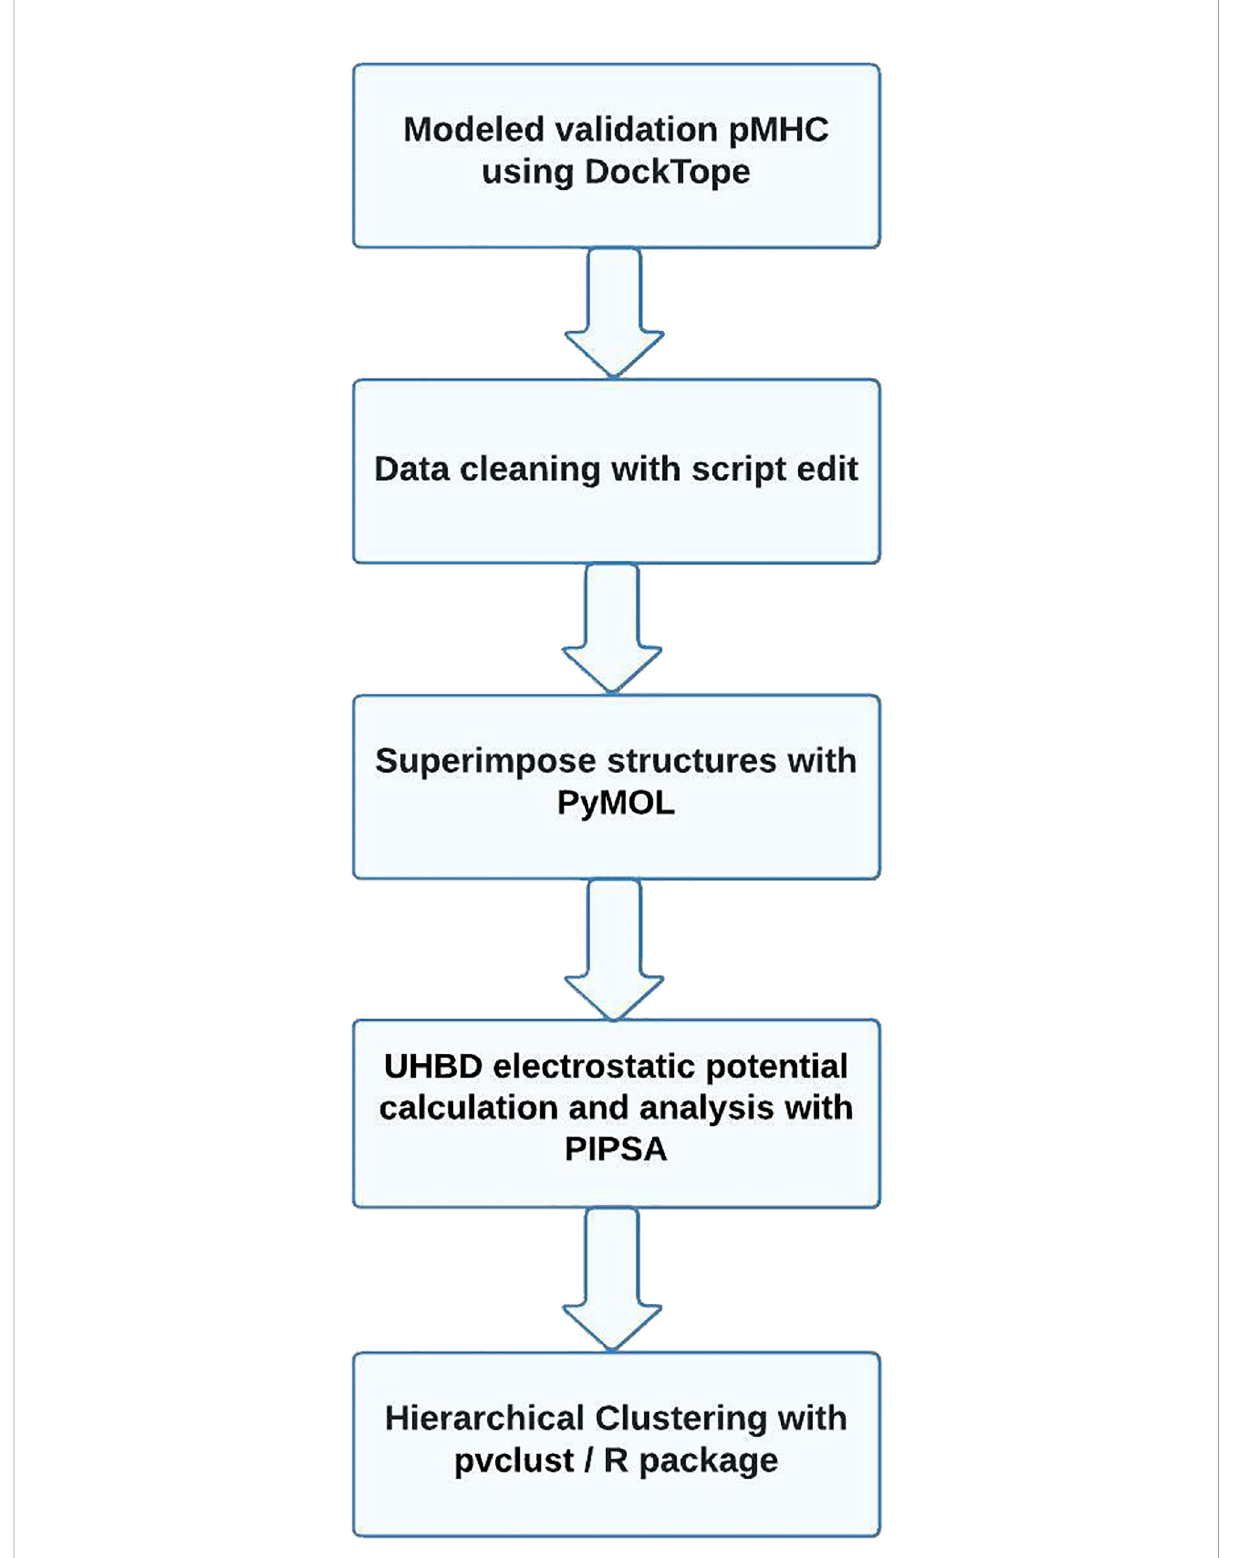
FIGURE 1 MatchTope fl owchart showing the analysis process from the fi rst step of inputting pdb fi les to the fi nal step of generating results. Each step is described in greater detail in the Methods